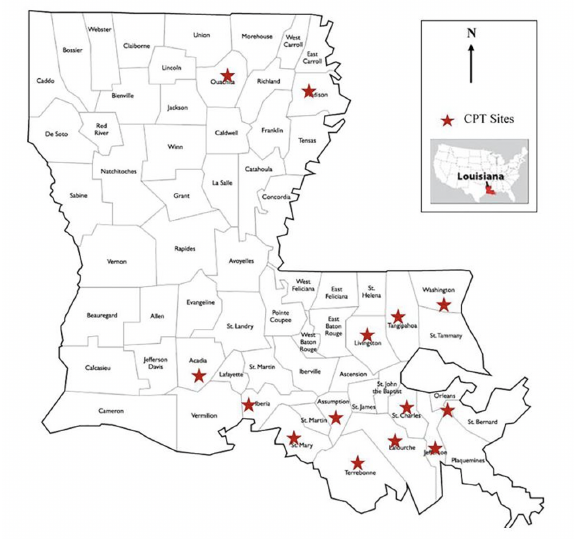
Fig. 1. Locations of cone penetration test (CPT) sites [11]